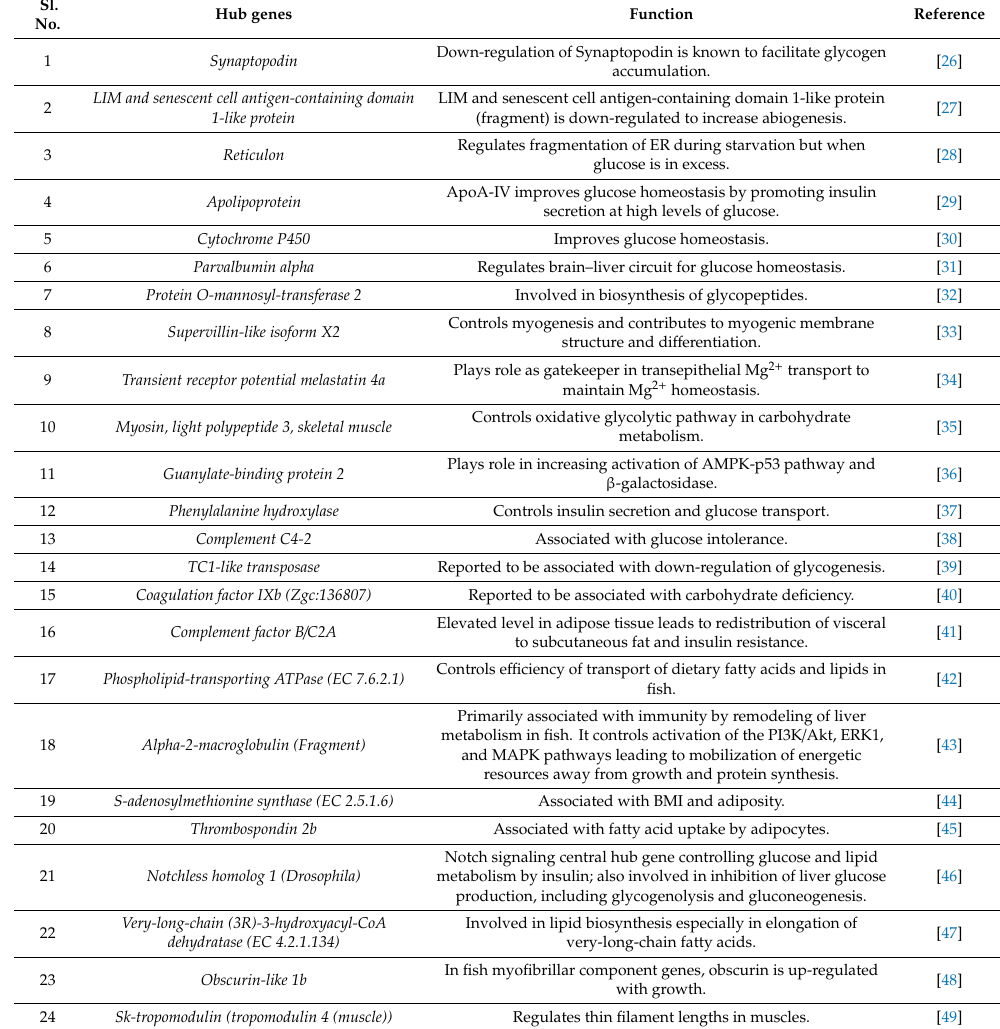
Table 3. The hub genes and their roles, and functional